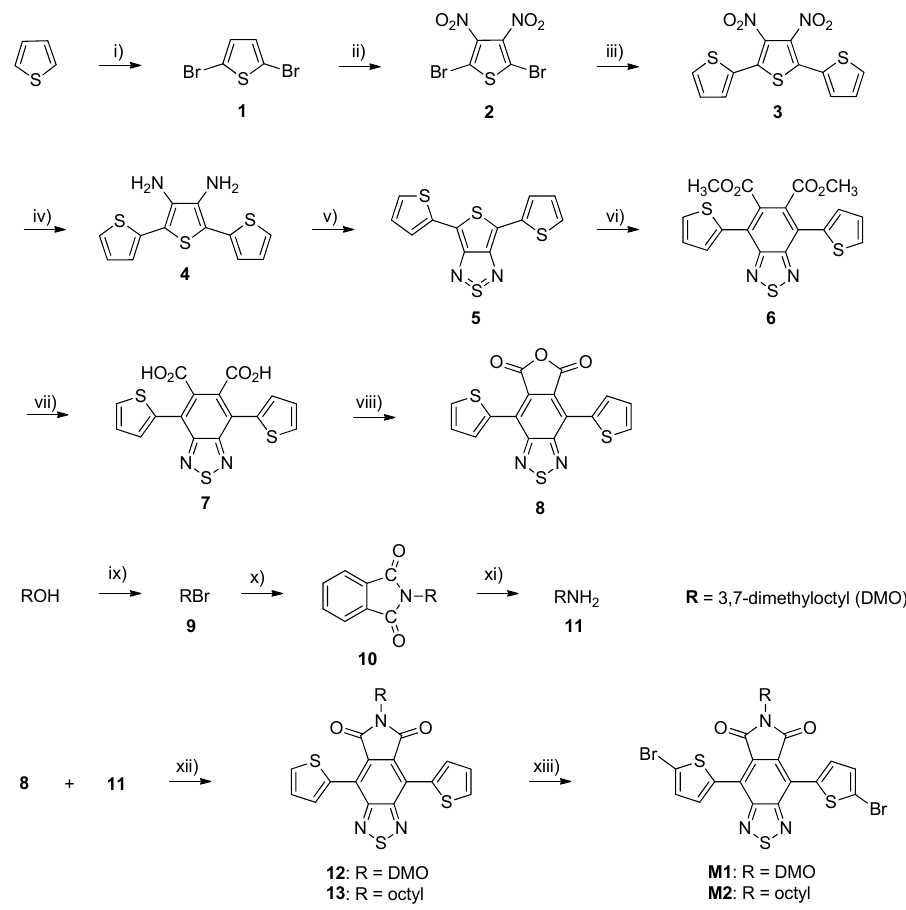
Scheme 1. Synthetic steps of the 4,7-di(5-bromo-thien-2-yl)-2,1,3-benzothiadiazole-5,6-N-(3,7-dimethy loctyl)dicarboxylic imide (M1) and 4,7-di(5-bromo-thien-2-yl)-2,1,3-benzothiadiazole-5,6-N-octyl- dicarboxylic imide (M2).